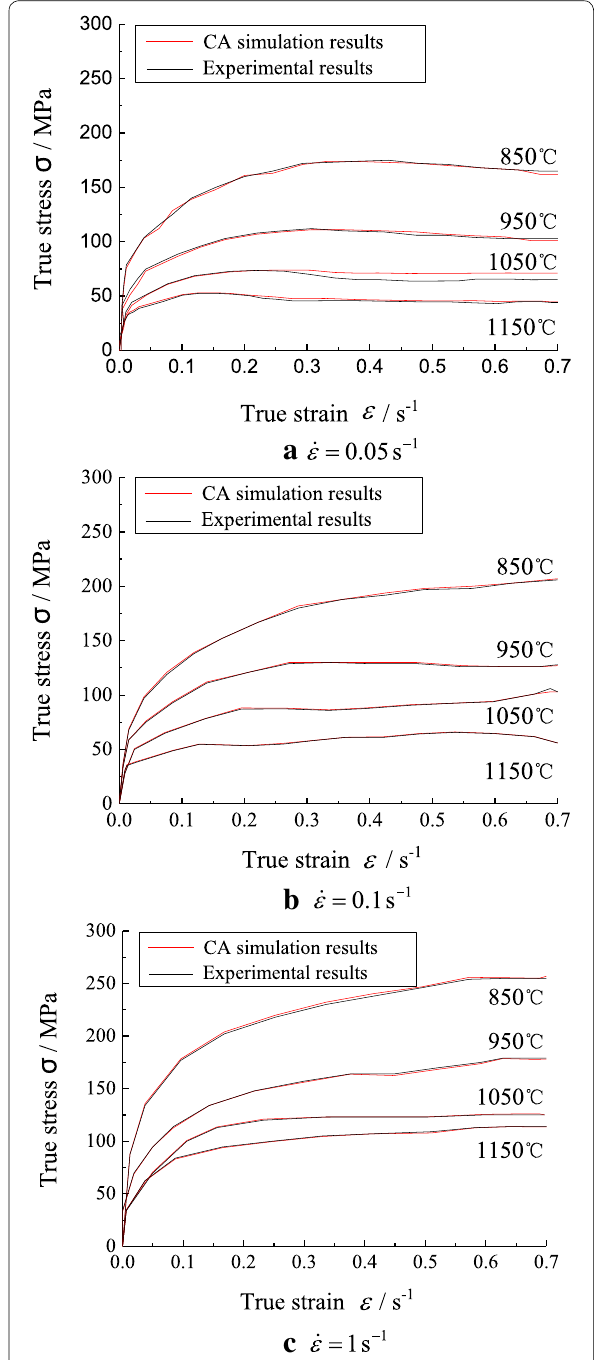
Figure 8 Comparison for CA model and experimental results at different strain rates